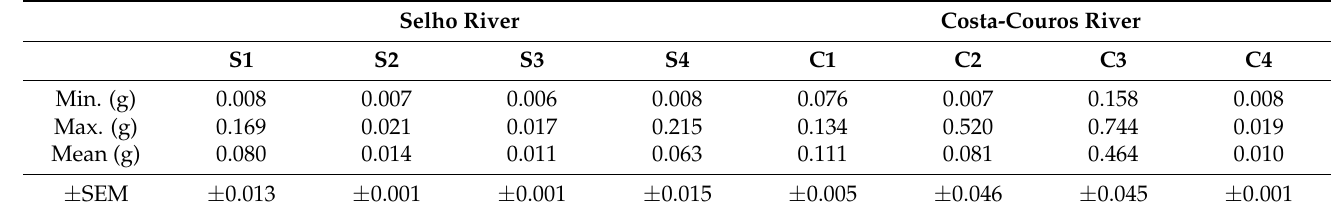
Table 5. Minimum, maximum, and mean ± SEM weight of the Oligochaeta collected from Selho (S1 to S4) and Costa-Couros (C1 to C4) rivers, analyzed after removing